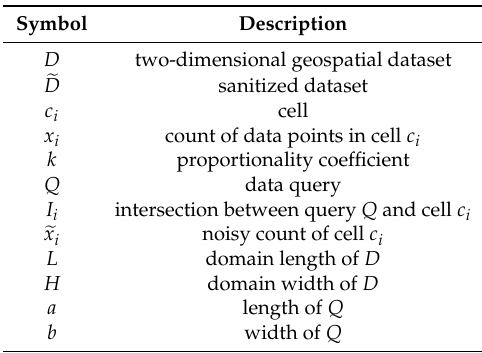
Table 1 is a summary of the primary symbols used in this paper. Table 1.